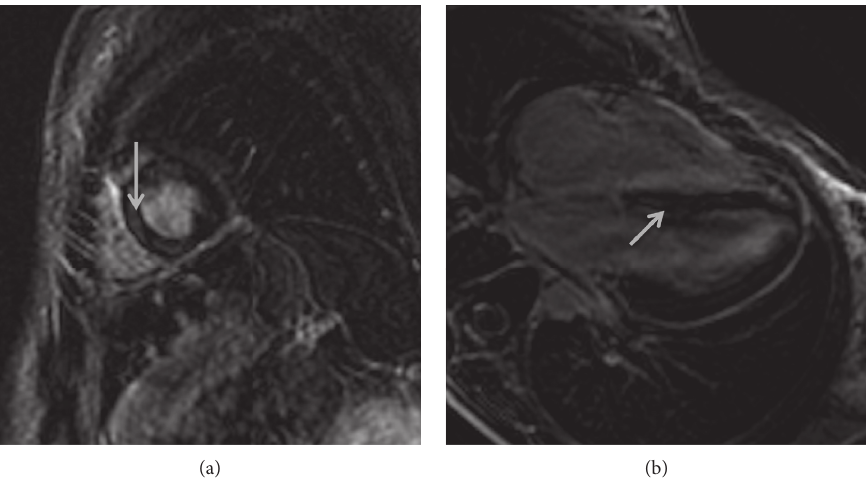
Figure 1: Initial T1-weighted delayed gadolinium-enhanced magnetic resonance images in (a) short axis and (b) four-chamber views demonstrating patchy midmyocardial delayed contrast enhancement in the anterior, inferior, and septal walls (arrows).